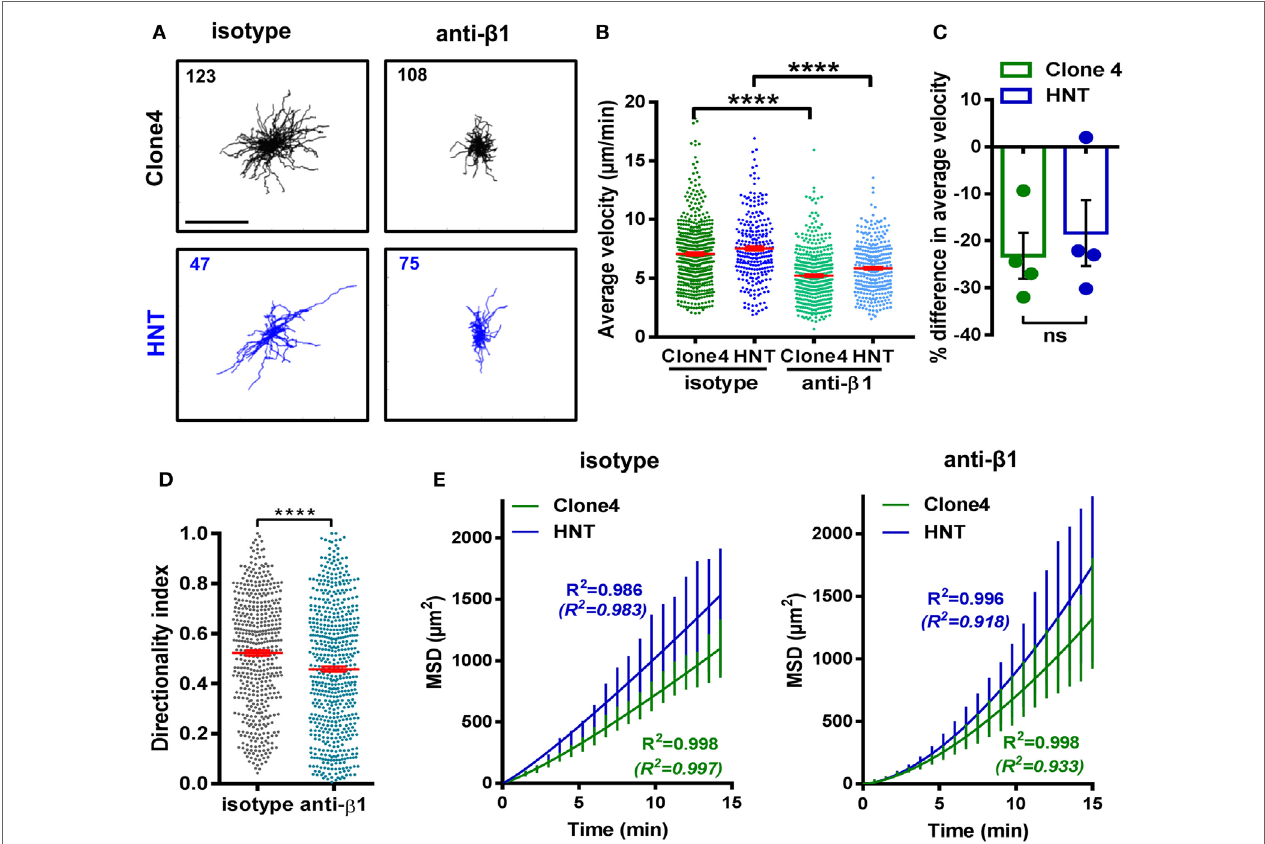
FigUre 5 | β 1 integrin-dependent interactions between T cells and the ECM shape T cell motility. Irradiated InsHA-mCherry mice transferred with Clone 4-GFP and HNT-CFP CD4 + T cells were subjected to intra-vital microscopy on day 8. (a) XY projections of T cell tracks over 15.2 min, 35 min after control IgG or anti- β 1 integrin injection (scale: 100 µm) (see also Video S5 in Supplementary Material). Values indicate the number of tracks in movies. (B) The average velocity of T cells in the exocrine tissue of isotype and anti- β 1 integrin-treated animals ( n = 3 mice/condition; 1–2 movies/mouse; one-way ANOVA). Dots correspond to individual cells. (c) Percentage difference in the average velocity between T cells in the exocrine tissue of isotype and anti- β 1 integrin-treated animals. Dots correspond to individual movies ( n = 3 mice/condition; 1–2 movies/mouse; P = 0.48, Mann–Whitney). (D) Directionality index of T cells in exocrine tissue ( n = 3 mice/condition; 1–2 movies/ mouse, Mann–Whitney). (e) MSD of T cells as a function time in the exocrine tissue of isotype and anti- β 1 integrin-treated animals were both best fitted with a model of Lévy-type super-diffusive migration (solid lines). Between brackets are R 2 -values of fit for Brownian random motility. Bars correspond to SEM ( n = 3 mice/CD8 + condition; 1–2